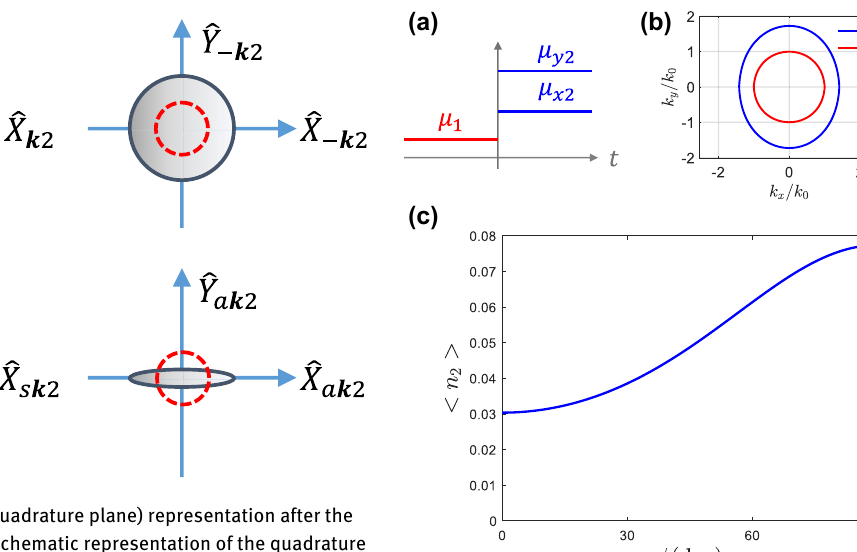
Figure 3. In conclusion, anisotropic temporal boundaries result in photon generation from vacuum, with nontriv- ial correlations between the photons propagating along opposite directions. In fact, the states depicted in Figure 3